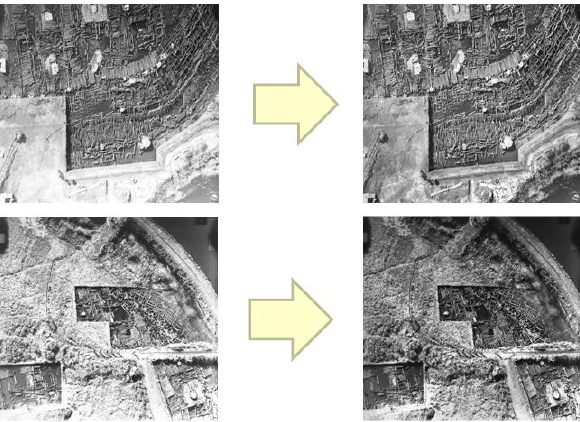
Figure 6: Examples of the radiometric correction of the selected photographs.